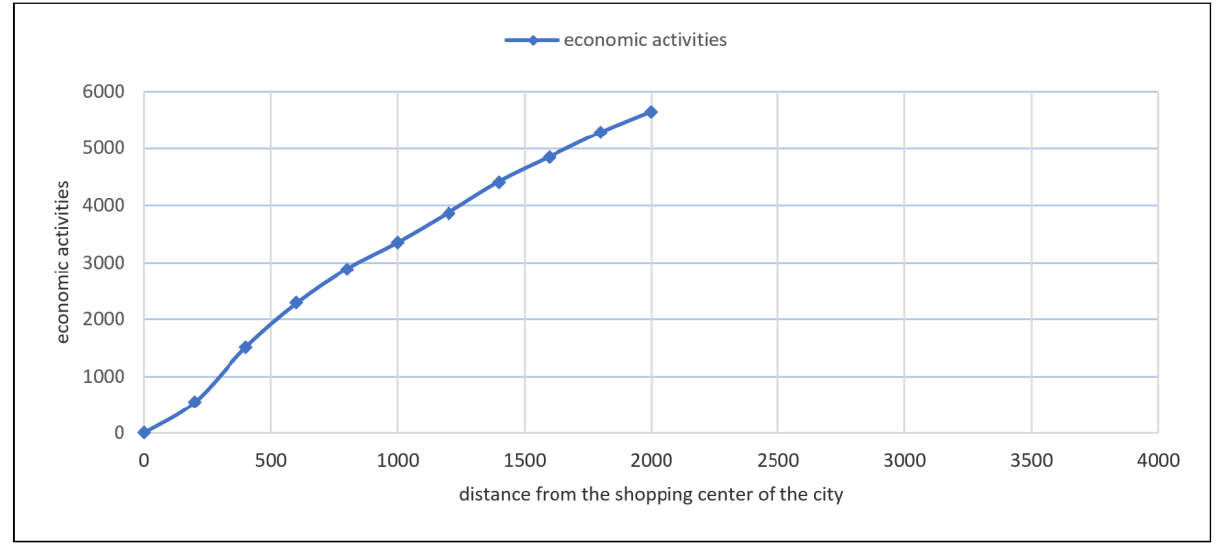
Figure 3. Number of economic activities and distance from the shopping center of the city. Source: Chamber of Magnesia, Own editing.